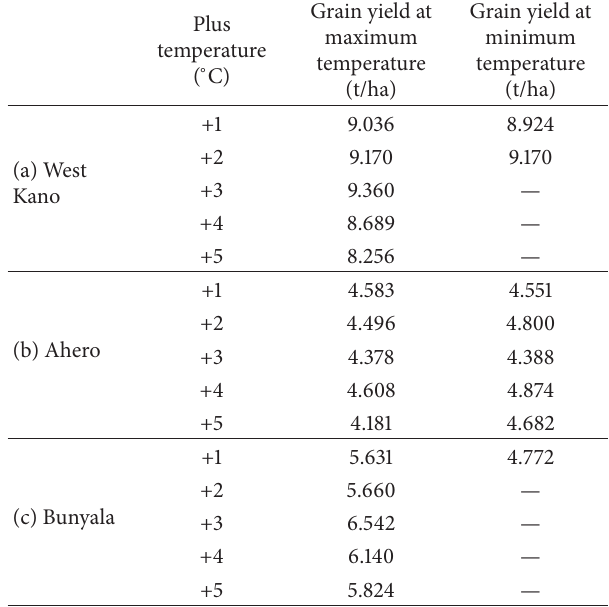
Table 7: Effects of temperature change on simulated IR 2793-80-1 grain yield under SRI in West Kano, Ahero, and Bunyala irrigation